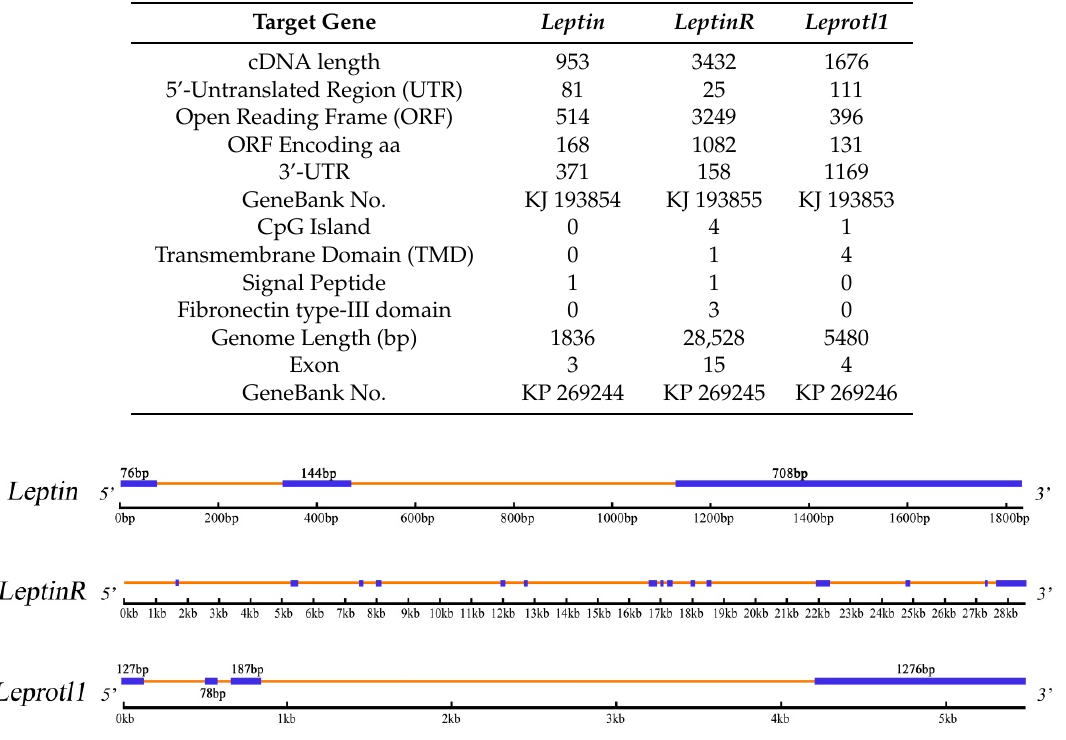
Table 1. The basic characterizations of three genes in M. amblycephala .